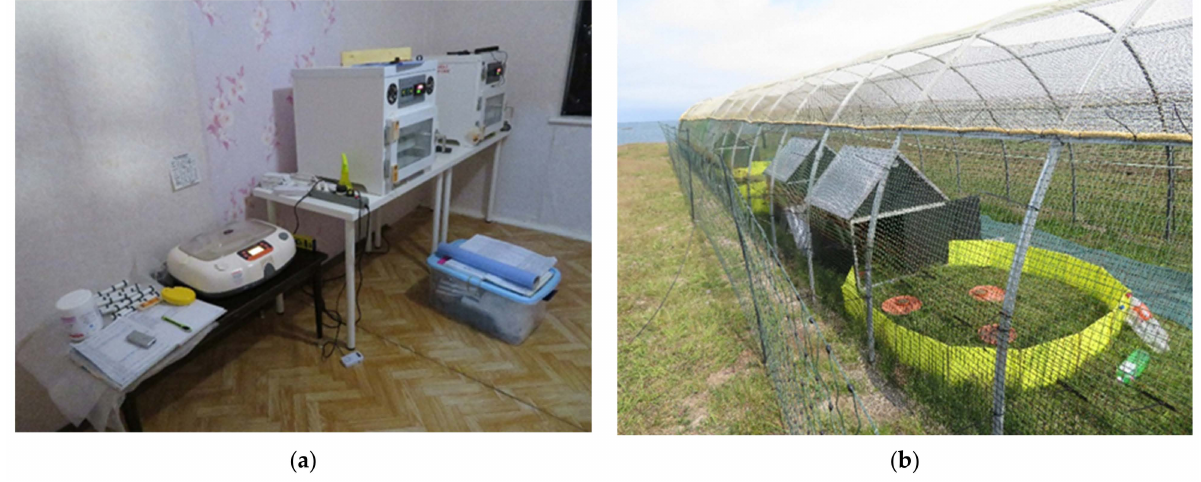
Figure 1. ( a ) Incubator at the rearing station and ( b ) the